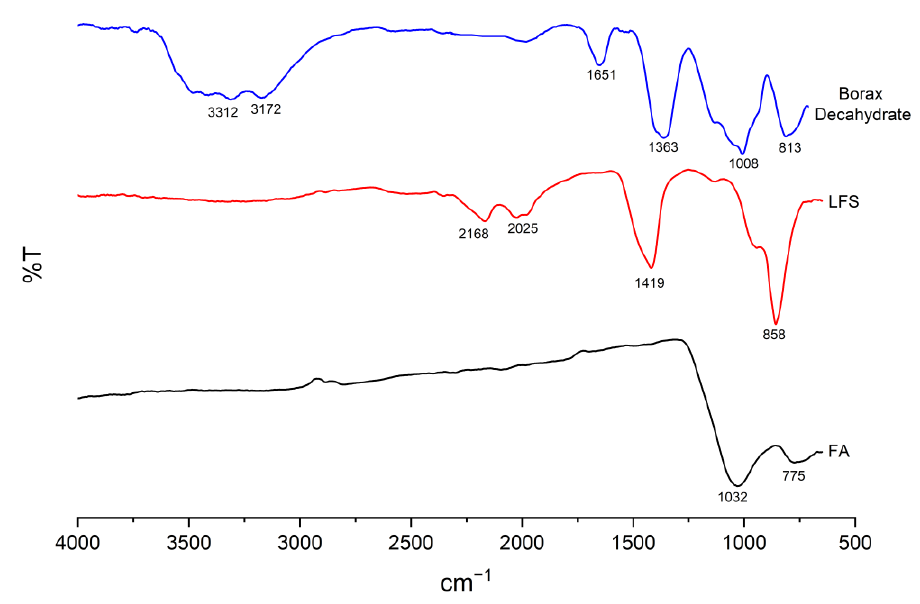
Figure 15. FTIR spectra of raw FA, LFS and borax decahydrate.